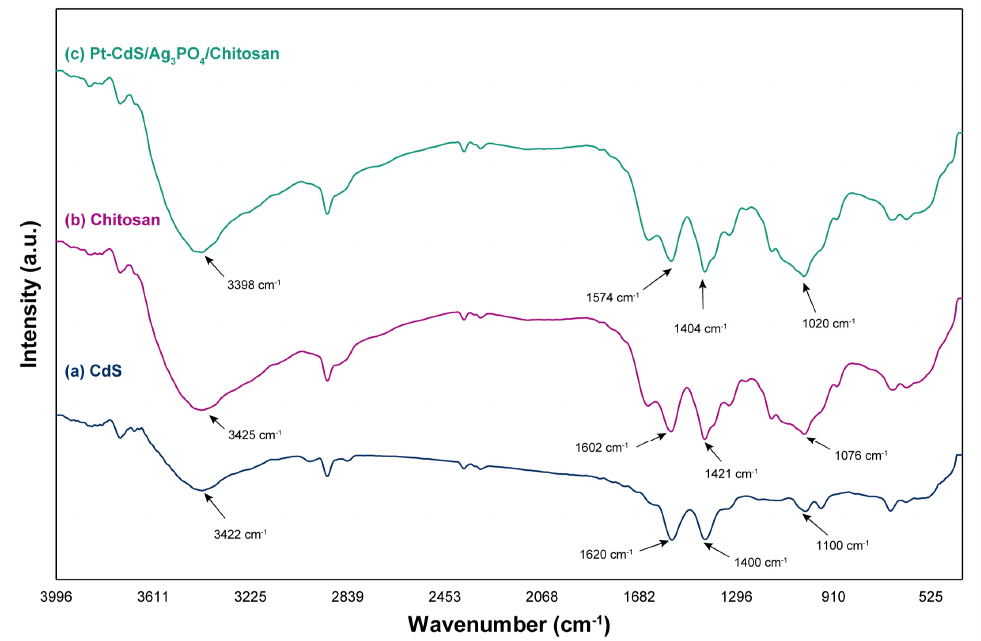
Figure 1. Fourier transform infrared (FTIR) spectra of ( a ) cadmium sulfide (CdS), ( b ) chitosan, and ( c ) Pt-Ag 3 PO 4 / CdS / chitosan (the spectrum of Ag 3 PO 4 was reproduced with permission from [32]; Copyright John Wiley & Sons,